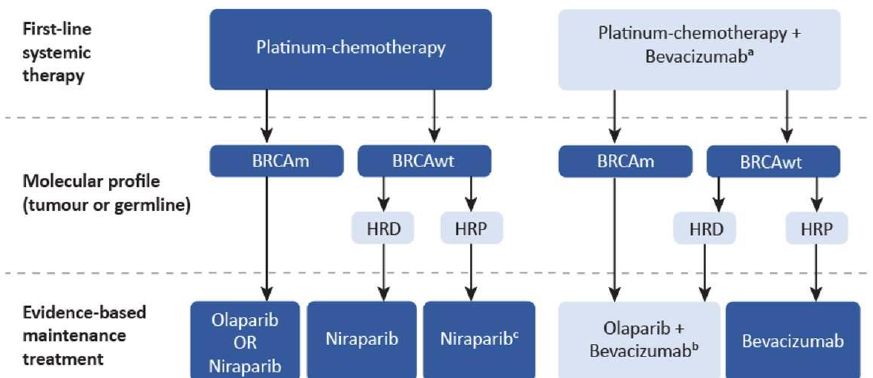
Figure 1. Maintenance treatment options for advanced stage, high-grade EOC following response to first-line platinum-based chemotherapy. EOC, epithelial tubo-ovarian cancer; HRD, homologous recombination repair deficiency; HRP, homologous recombination repair proficiency; m, mutated; wt, wild-type. Light blue indicates testing/treatment with variable access in Canada as of March 2022. a Funded in most provinces in the first-line setting for patients with high-risk disease defined as stage III sub-optimally debulked, stage III unresectable, or stage IV disease. b Not approved by Health Canada. c Weigh risks/benefits of starting niraparib on individual basis considering patient and disease factors.